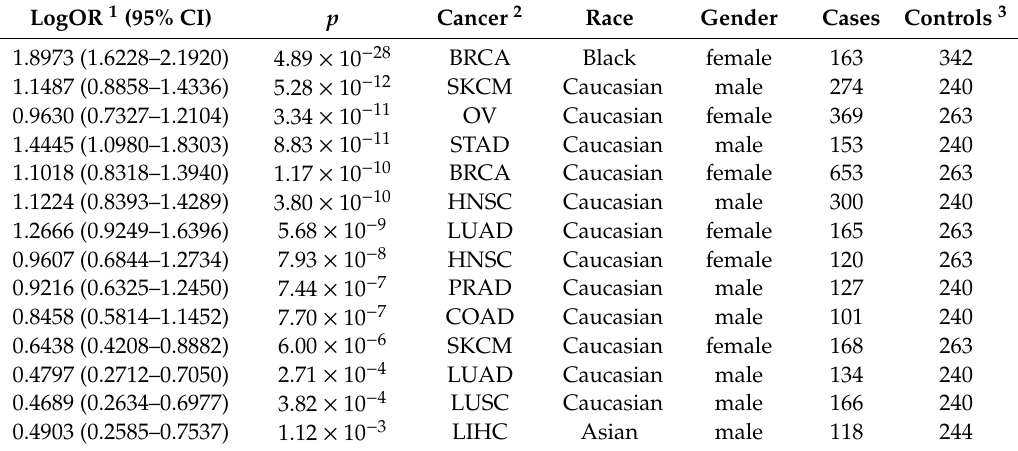
Table 1. Results from logistic regression assessing HRNonRef’s cancer risk.